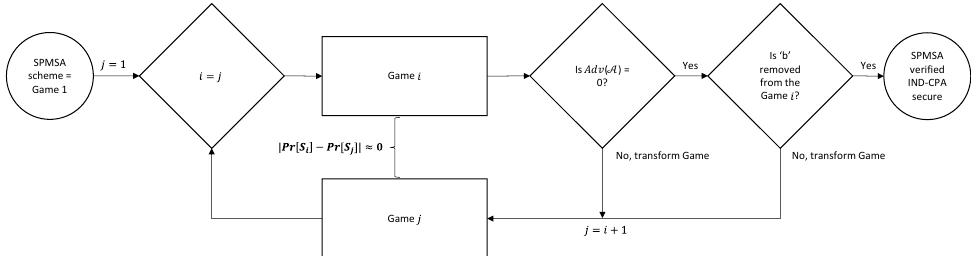
Figure 9. Game-Hopping to Verify IND-CPA Property of Platoon Key Update Phases.